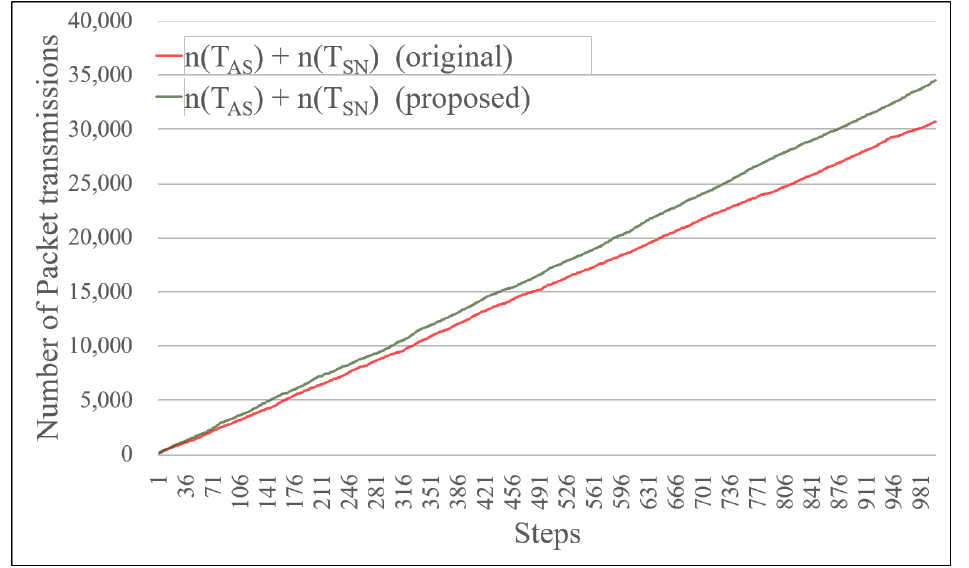
Figure 7. Number of packets transmitted in the access stratum (AS)